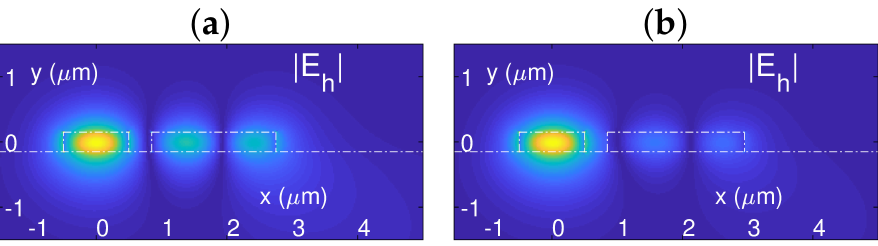
Figure 7. Amplitudes of the horizontal main electric field components of the TE modes propagating in the asymmetric concentric microring structure of Figure 1 with R = 50 µ m. The plots correspond to the third (green) and fourth (red) sheets, respectively, in that figure. Plots ( a , b ), are for the same value of s = 0.85 µ m and respective values of w e of 1.9 and 2.1 µ m. The waveguide boundaries are outlined with a dashed white